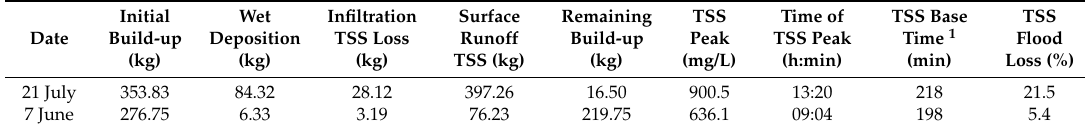
Table 4. Summary information of simulated TSS for calibration and validation